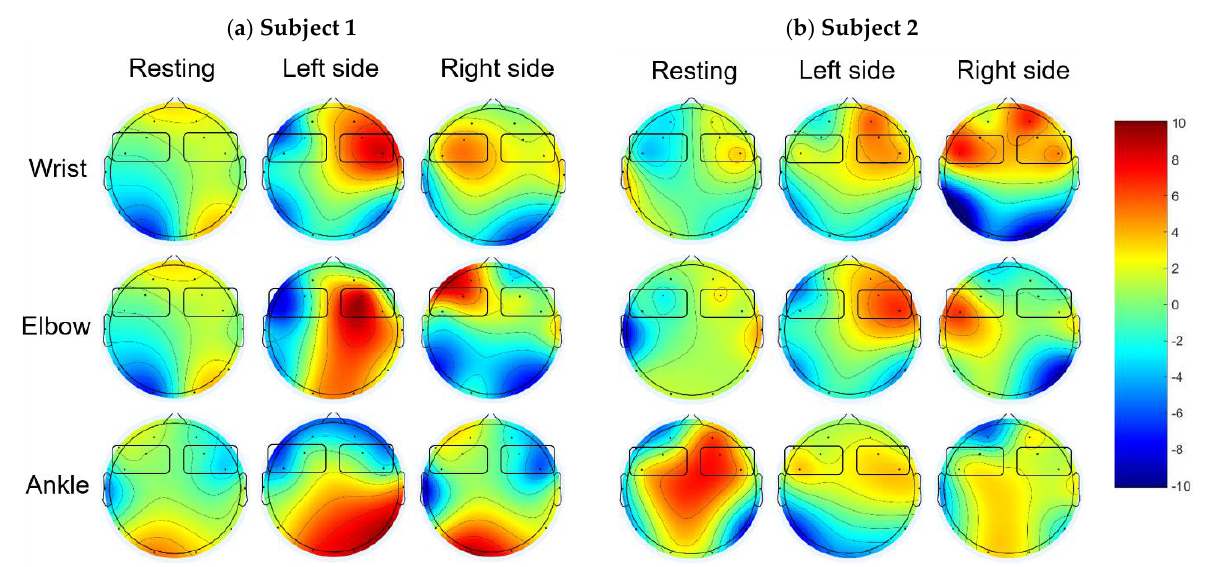
Figure 5. Examples of topographic brain maps of alpha ERD (10 – 12 Hz) from EEG while subjects 1 and 2 performed motor imagery tasks with left/right side of wrist, elbow, and ankle movements.